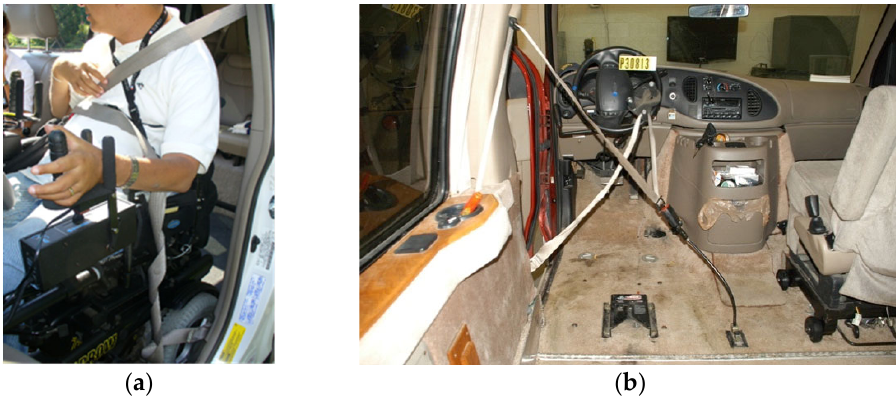
Figure 6. Driver using vehicle belt with poor fit ( a ) and a “drive ‐ in” belt arrangement ( b ).